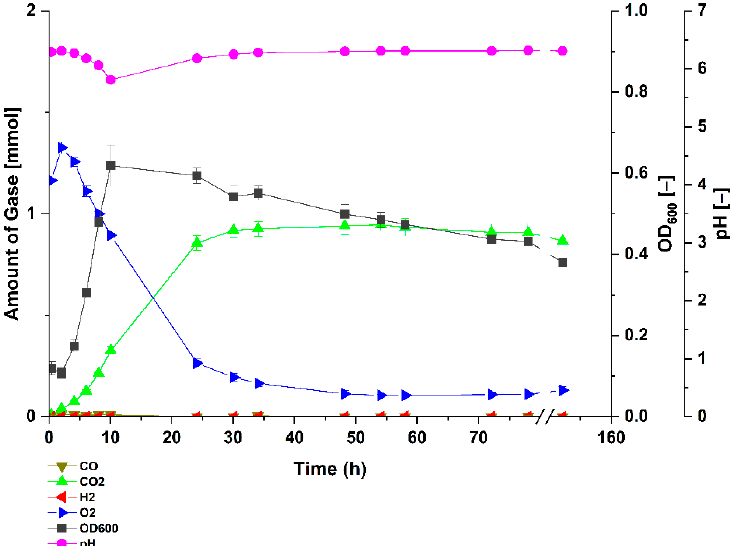
Figure 1. Gas composition and growth of P. thermoglucosidasius DSM 6285 cultivated under 0% carbon monoxide atmosphere. The strain was grown in stoppered 250 mL serum bottles containing 50 mL of modified ASM medium and an initial O 2 concentration of ~1.2 to 1.4 mmol (40 mL at 1 bar pressure). Reported values represent means of triplicate experiments ± standard deviation.